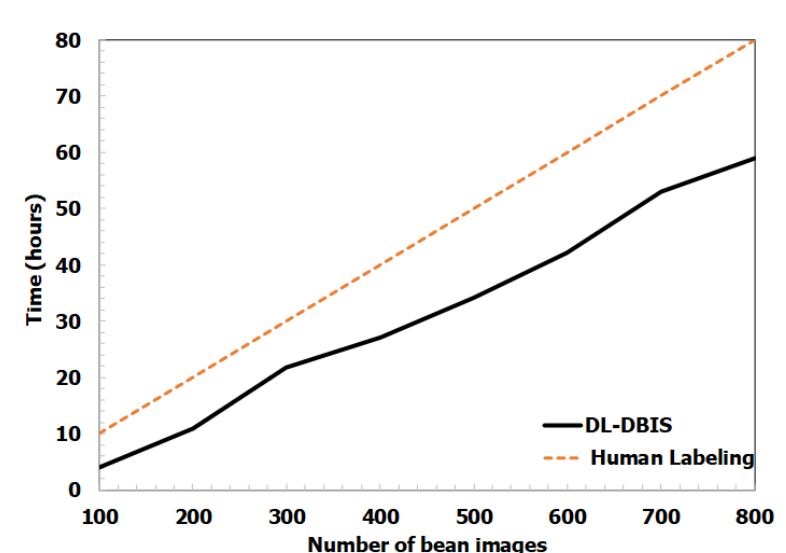
Figure 18. Comparison of labeling time between the proposed deep-learning-based defective bean inspection scheme (DL-DBIS) and human